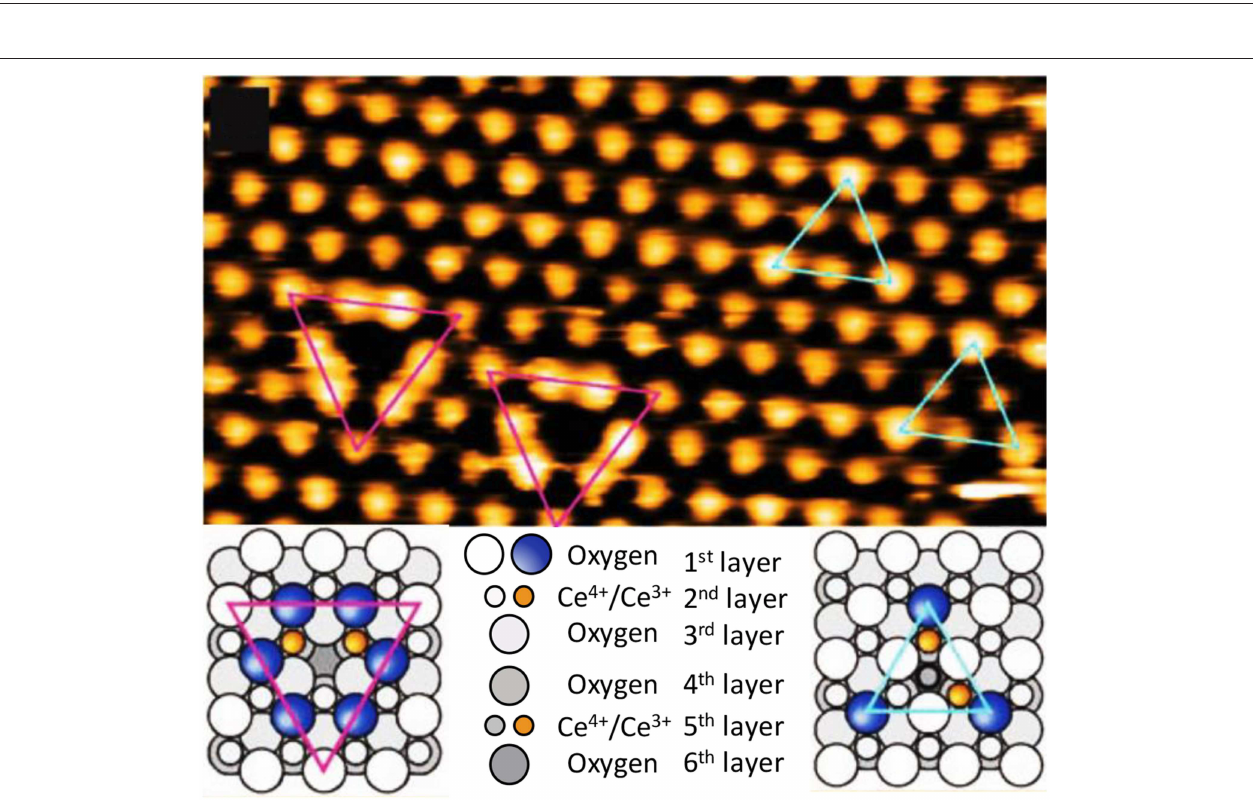
FIGURE 2 | STM images of oxygen in the CeO 2 facet (111) (adapted from Esch et al., 2005).